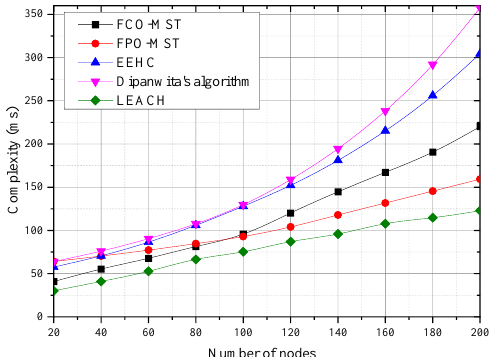
Figure 15. The comparison of complexity.